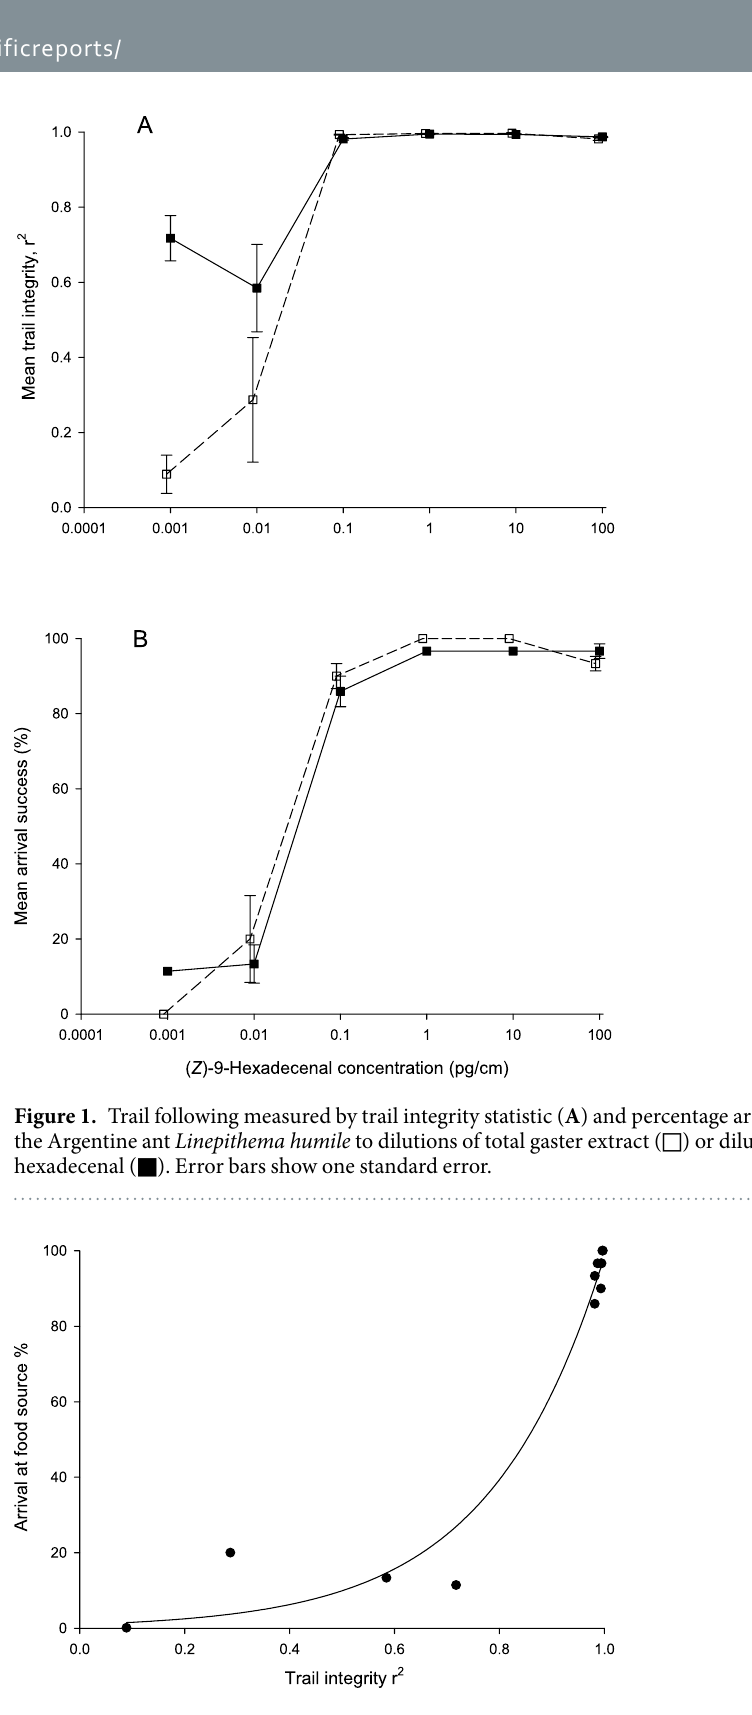
Figure 2. Correlation between Argentine ant Linepithema humile trail integrity and foraging success with an exponential function from pooled gaster extract and synthetic trail results, Y = e 4.5913x , r 2 =